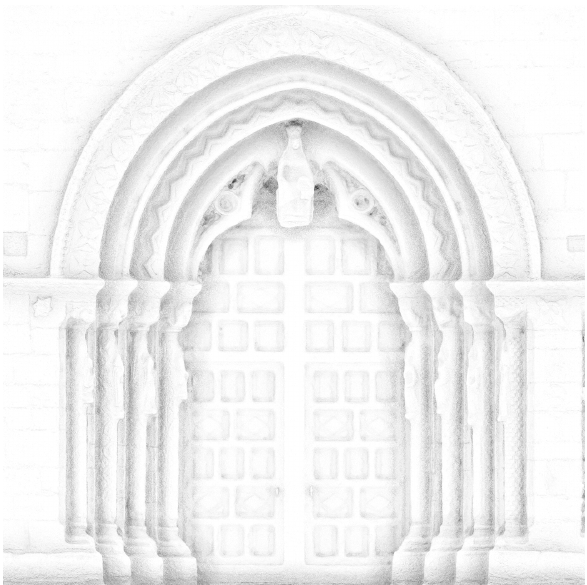
Figure 7: Map with the ambient occlusion shading produced by the diffuse component of the light-map.